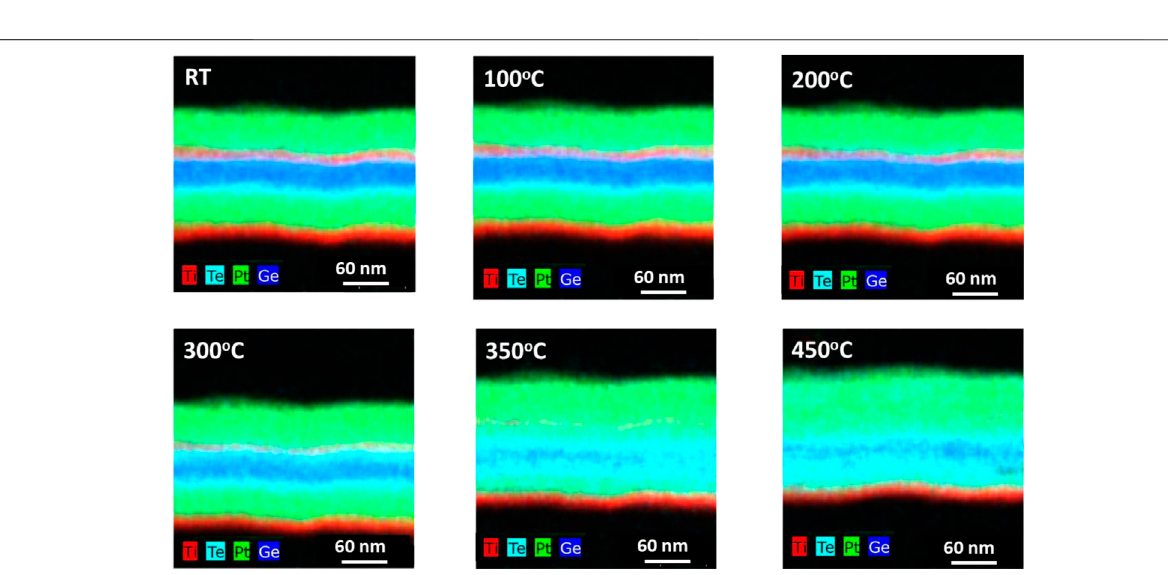
FIGURE 9 | Composite XEDS elemental maps obtained from in-situ heating experiments starting at room temperature (RT), showing in-diffusion of Ti into the Ge 2 Te 3 layer with increase in